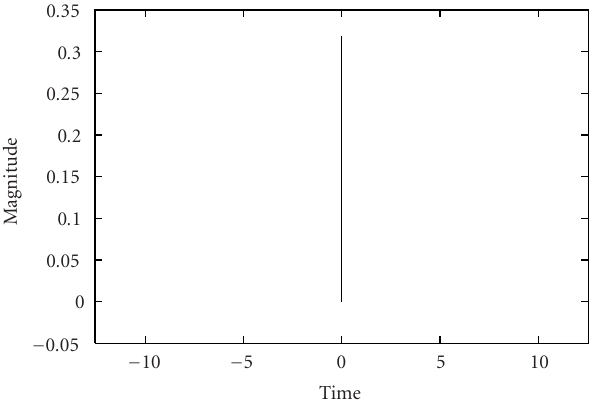
Figure 4.3. Samples of sinc-function.